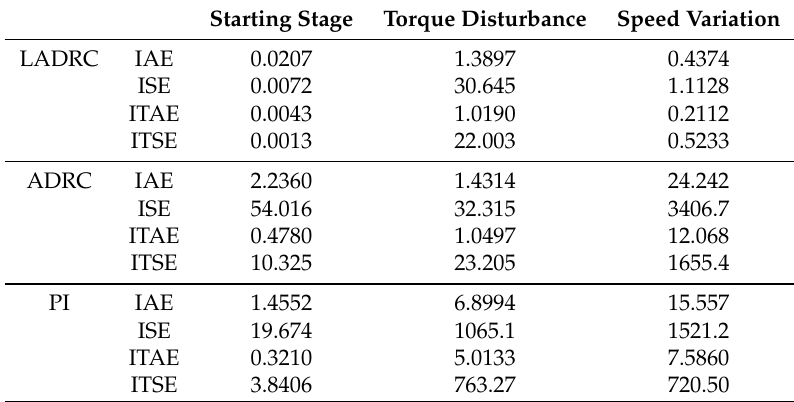
Table 3. Performance indices of the speed control loop.